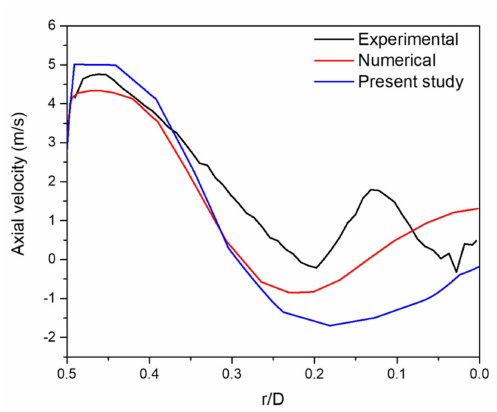
Figure 5. Grid dependency test.